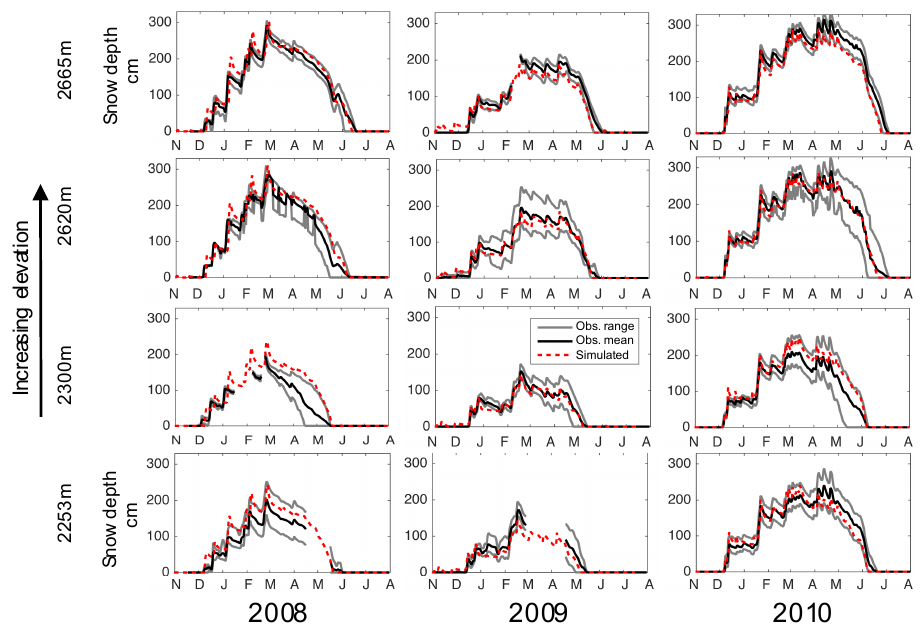
Figure 4. Comparison of three years (panel columns) of daily ( x axes) simulated (red lines) snow depth and the six-sensor observed range (gray lines) and mean (bold lines) snow depth measured by automated sensors at four research sites (panel rows) at different elevations in the Wolverton basin.